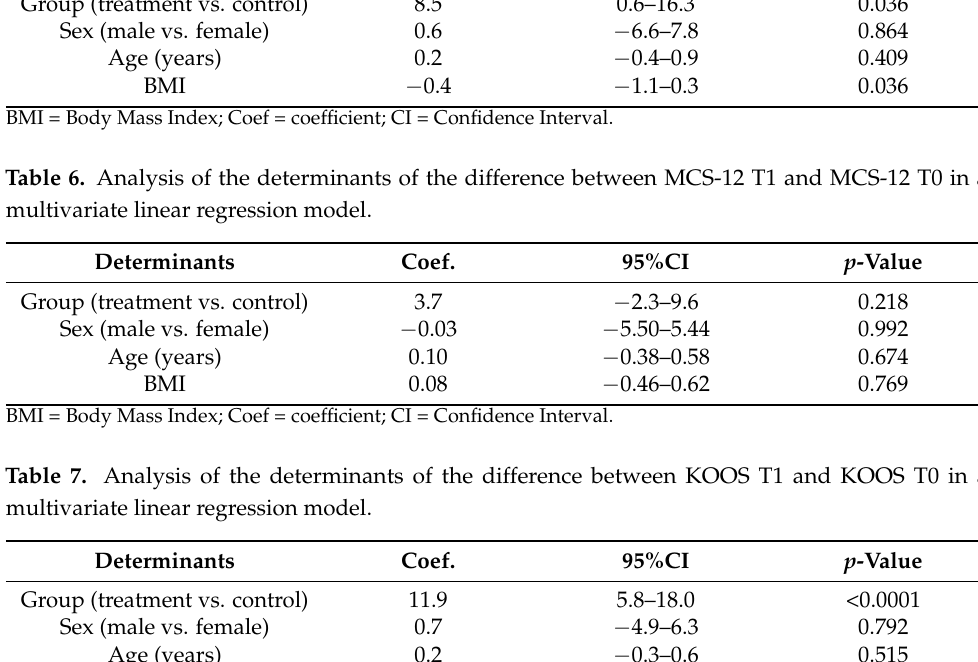
Table 5. Analysis of the determinants of the difference between PCS-12 T1 and PCS-12 T0 in a multivariate linear regression model. Determinants Coef. 95%CI p -Value Group (treatment vs. control)